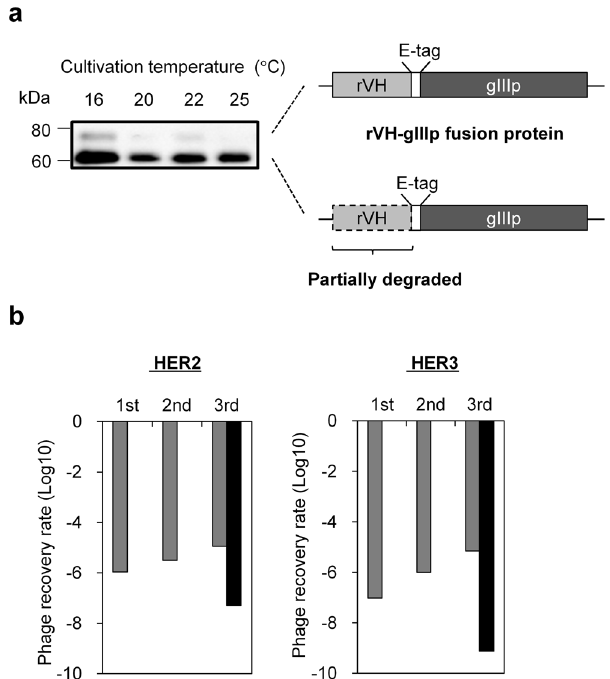
Figure 1. Panning against antigens with rVH-displaying phage. ( a ) Display level of rVHs on the phage produced at various temperatures. The phages were produced at 16, 20, 22 and 25 °C and subjected to WB (1.0 × 10 10 virions per well). The rVH-gIIIp fusion protein was detected by anti-E-tag antibody and the amount of detected rVH-gIIIp fusion protein was correlated to the display level of rVHs. Fusion protein, which lacks an rVH portion, was also detected as a below band of the intact fusion protein. ( b ) Phage recovery rates after panning against HER2 or HER3. Gray bars indicate phage recovery rates (ratio of output to input phage) after each round of panning and black bars indicate phage recovery rates after the third round of panning without